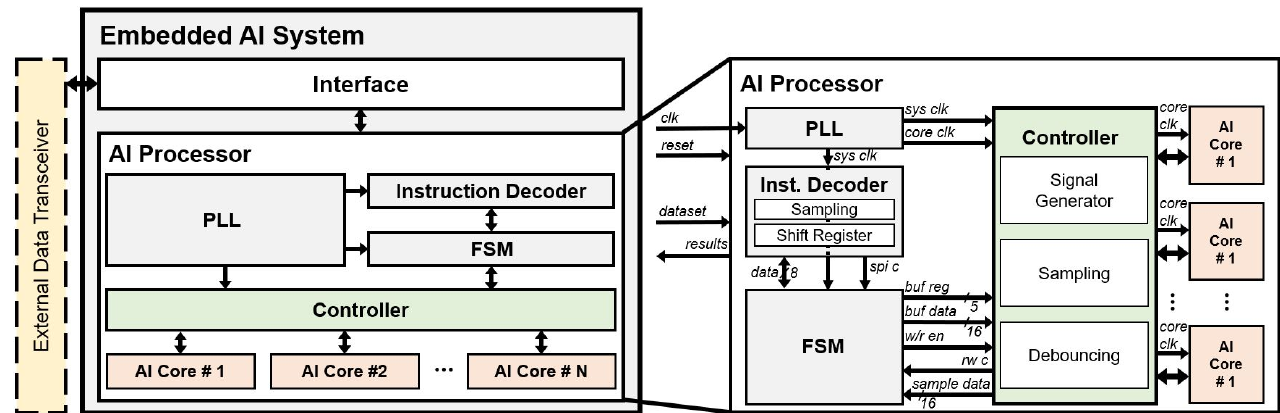
Figure 3. Block diagram of embedded AI system and AI processor in detail .